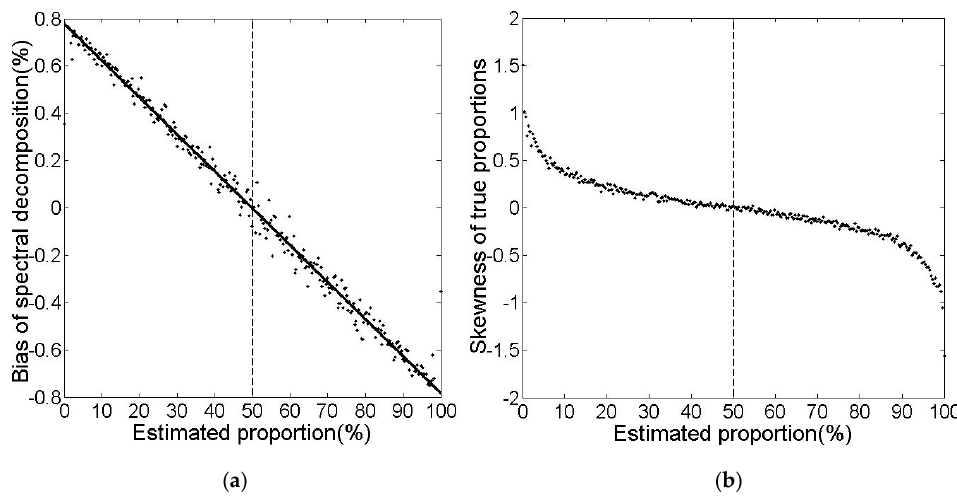
Figure 4. Bias of the spectral unmixing and skewness of the true proportion distribution versus the estimated proportion. The solid line in ( a ) is the linear fitting curve of the bias, and the dashed lines in ( a ) and ( b ) indicate an estimated proportion of 50%.